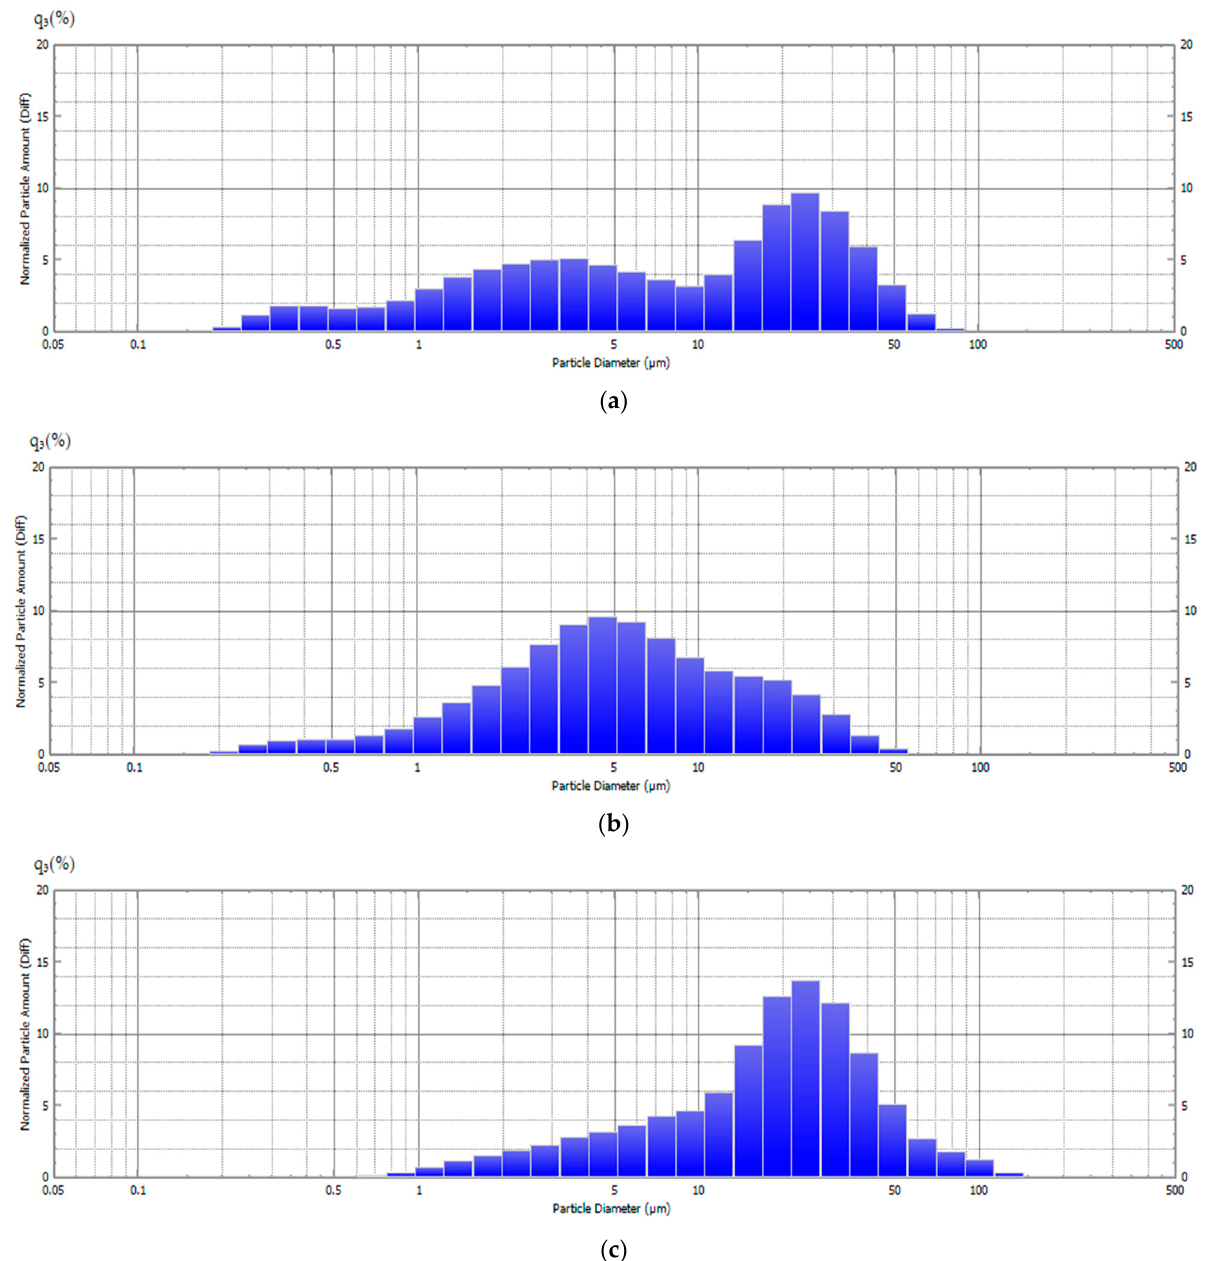
Figure 8. Particle-size distribution of the powder SCS product at various φ after calcination: ( a ) φ = 0.25, D 50 = 9.0 μ m; ( b ) φ = 1, D 50 = 5.1 μ m; ( c ) φ = 2, D 50 = 19.8 μ m. ( a ) ϕ = 0.25, D 50 = 9.0 µ m; ( b ) ϕ = 1, D 50 = 5.1 µ m; ( c ) ϕ = 2, D 50 = 19.8 µ